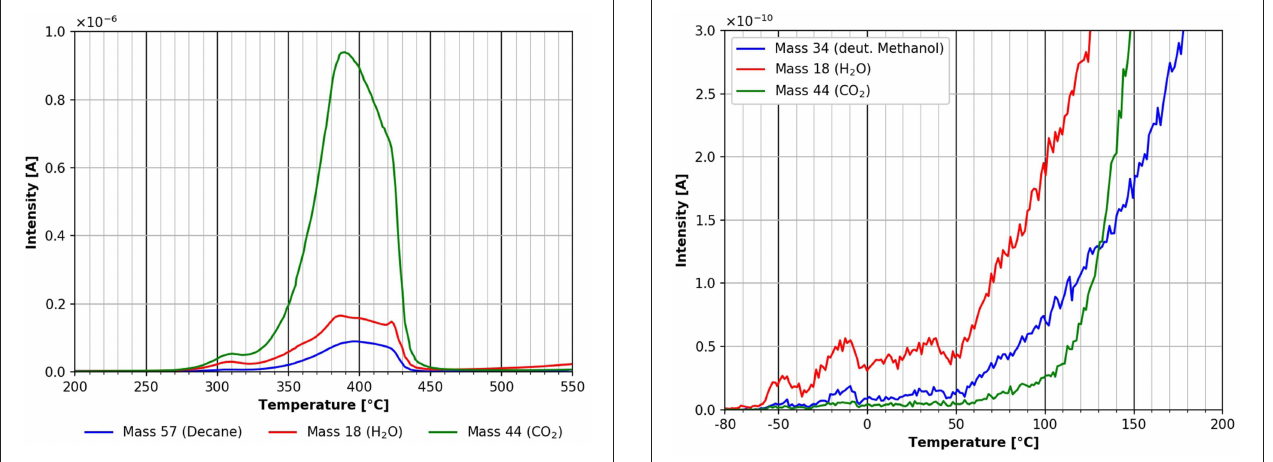
FIGURE 11 | Zoom into the desorption of deuterated methanol (mass 34, blue), carbon dioxide (mass 44, green) and water (mass 18, red) in the temperature range between − 80 and 200 ◦